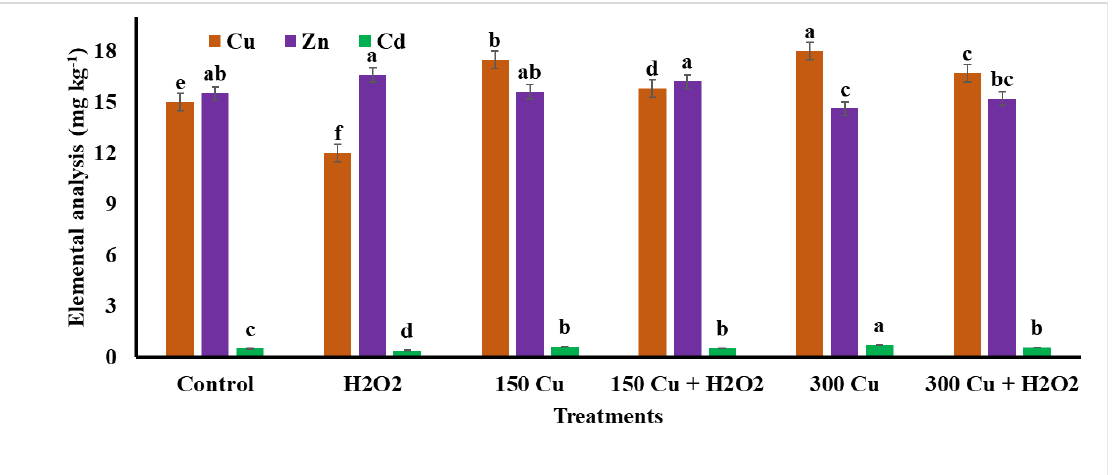
Figure 9. Effect of hydrogen peroxide on elemental analysis of whole wheat plants grown in con- taminated sandy soil. Means followed by the same letter in each parameter are not significantly different according to the least significant differences (LSD) test ( p ≤ 0.05). Error bars are ± Standard Error (SE).